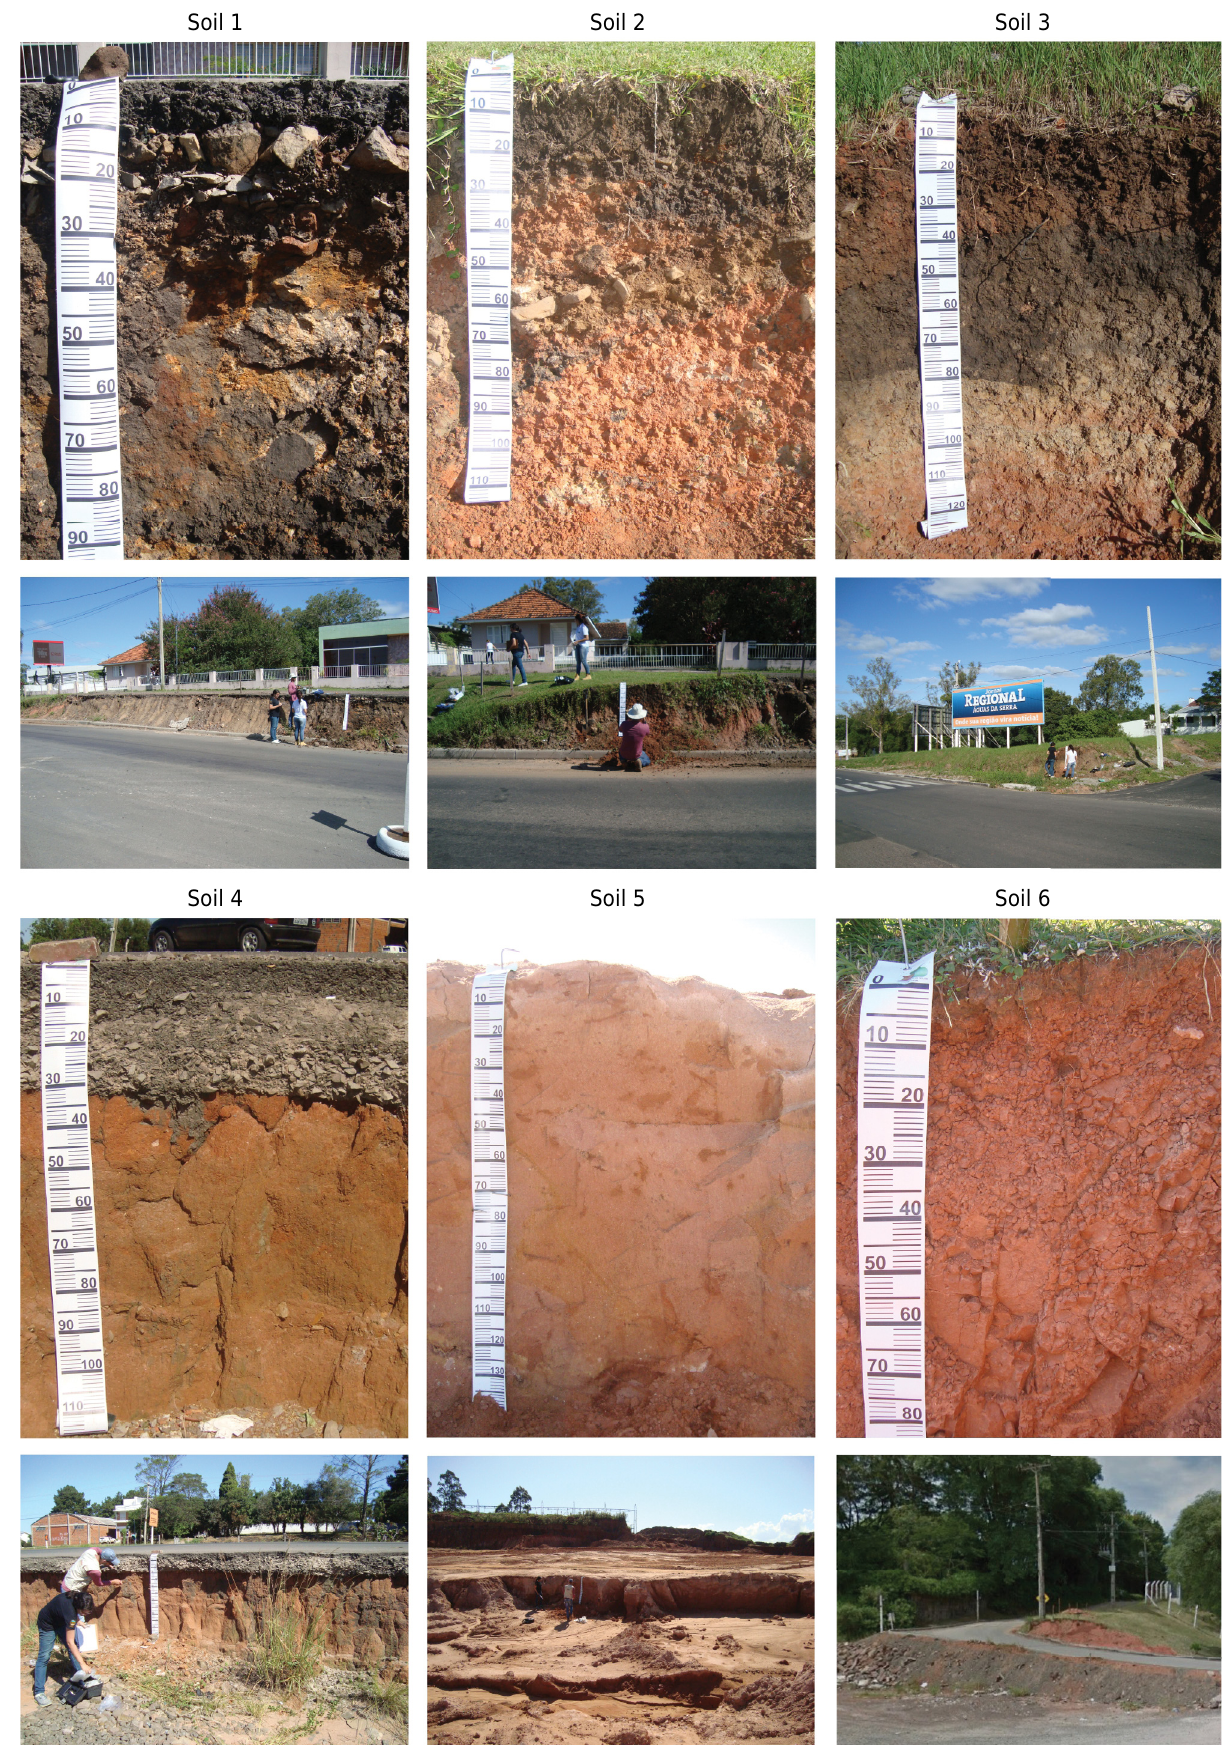
Figure 2. Soil profiles and landscapes (1 to 6) in the urban area of Santa Maria, Rio Grande do Sul State,